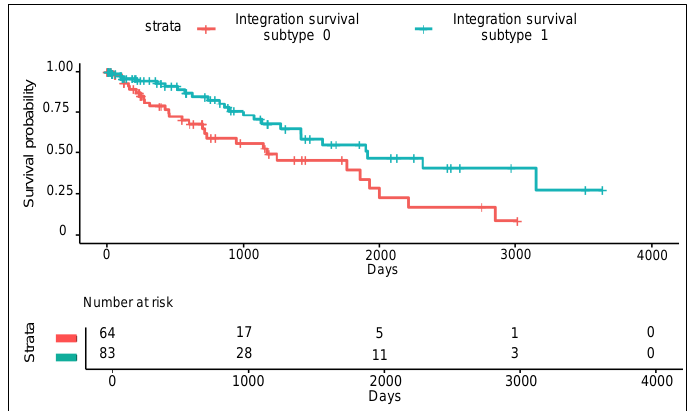
Figure 4. Kaplan-Meier survival curve of the RPPA uncommon dataset using the integration survival subtypes.